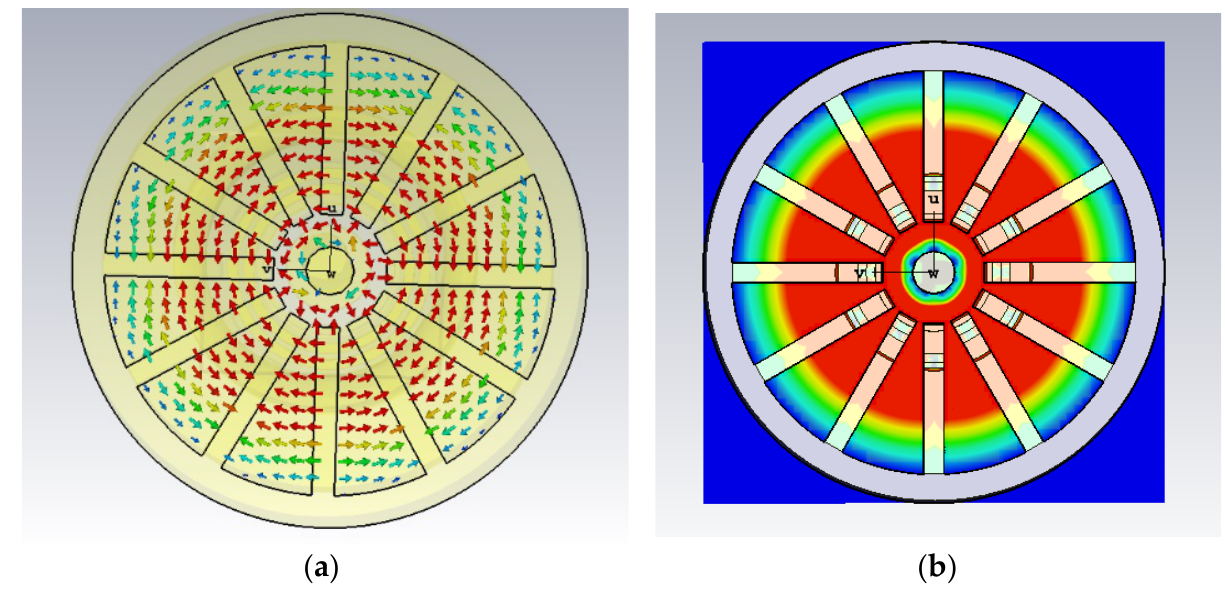
( b ) Figure 1. CST Particle Studio simulation model of the 12-vanes and 2.45 GHz CW magnetron. ( a ) Appearance and structure diagram of the magnetron. ( b ) Internal structure diagram of the magne- tron. 3. Eigenmode and Frequency-Domain Simulation The simulation results of the designs are presented in this section. CST Microwave Studio was used for simulations. As can be observed in Figure 2, the electric field in the cavity direction was strictly positive and had negative spacing during the mode simulation phase. When in π -mode,